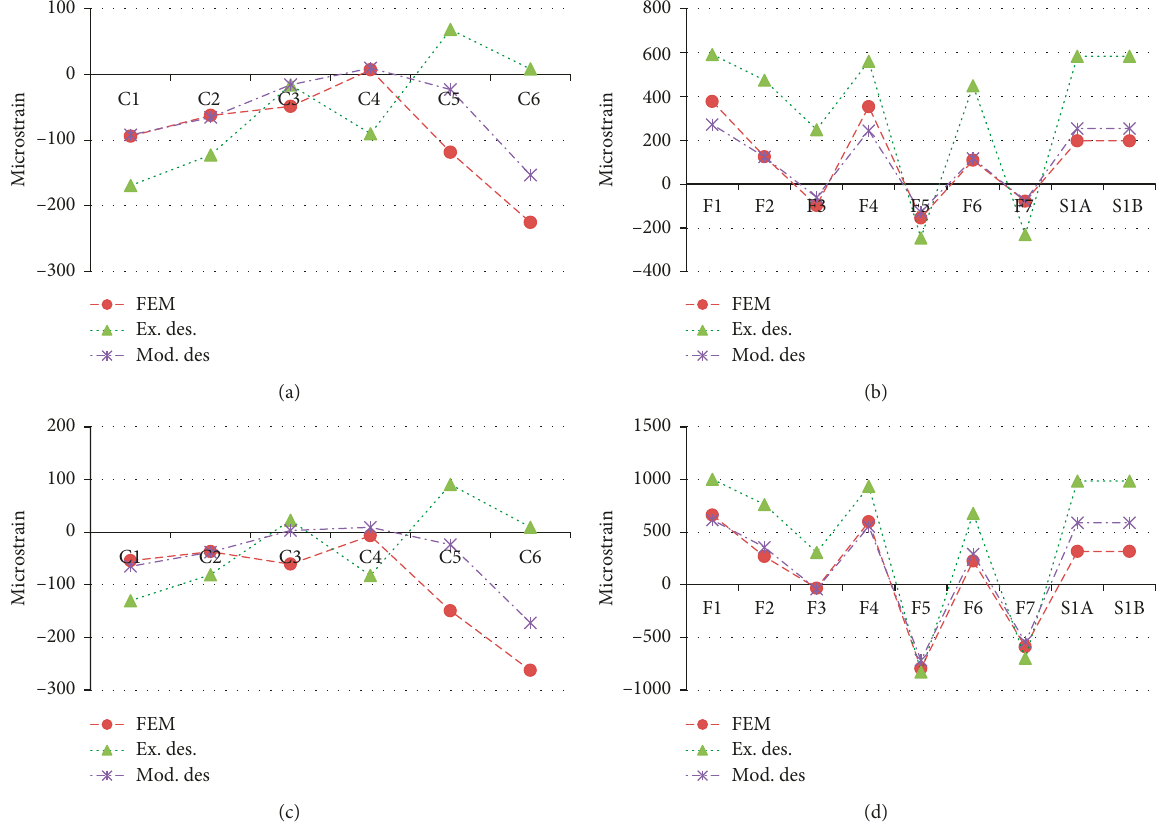
Figure 7: Strain values due to the deck pour (stage 2) and total loads of the three stages. (a) Concrete VWSGs (stage 2). (b) FRP and steel gauges (stage 2). (c) Concrete VWSGs (total load). (d) FRP and steel gauges (total load).